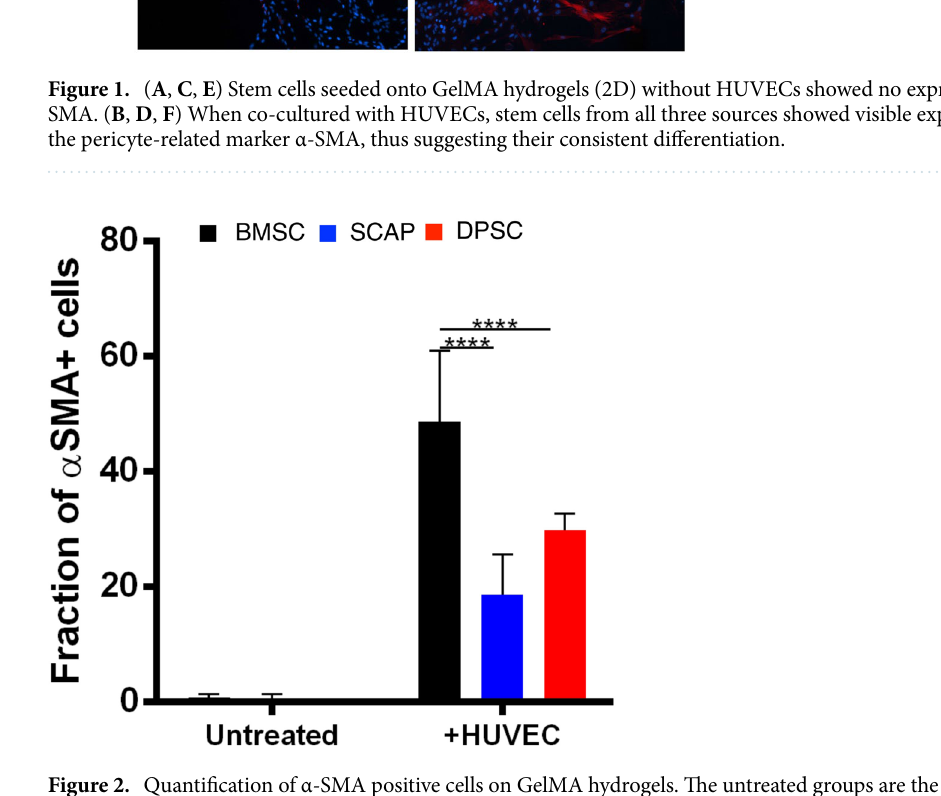
Figure 2. Quantification of α-SMA positive cells on GelMA hydrogels. The untreated groups are the monocultured stem cells without HUVECs, i.e., the BMSC, SCAP and DPSC. The untreated groups hardly expressed any α SMA positive cells. However, when cocultured with HUVECs, the stem cells differentiated to express α-SMA. The number of α-SMA positive cells was higher in BMSC system followed by DPSC and SCAP cells. (**** p <